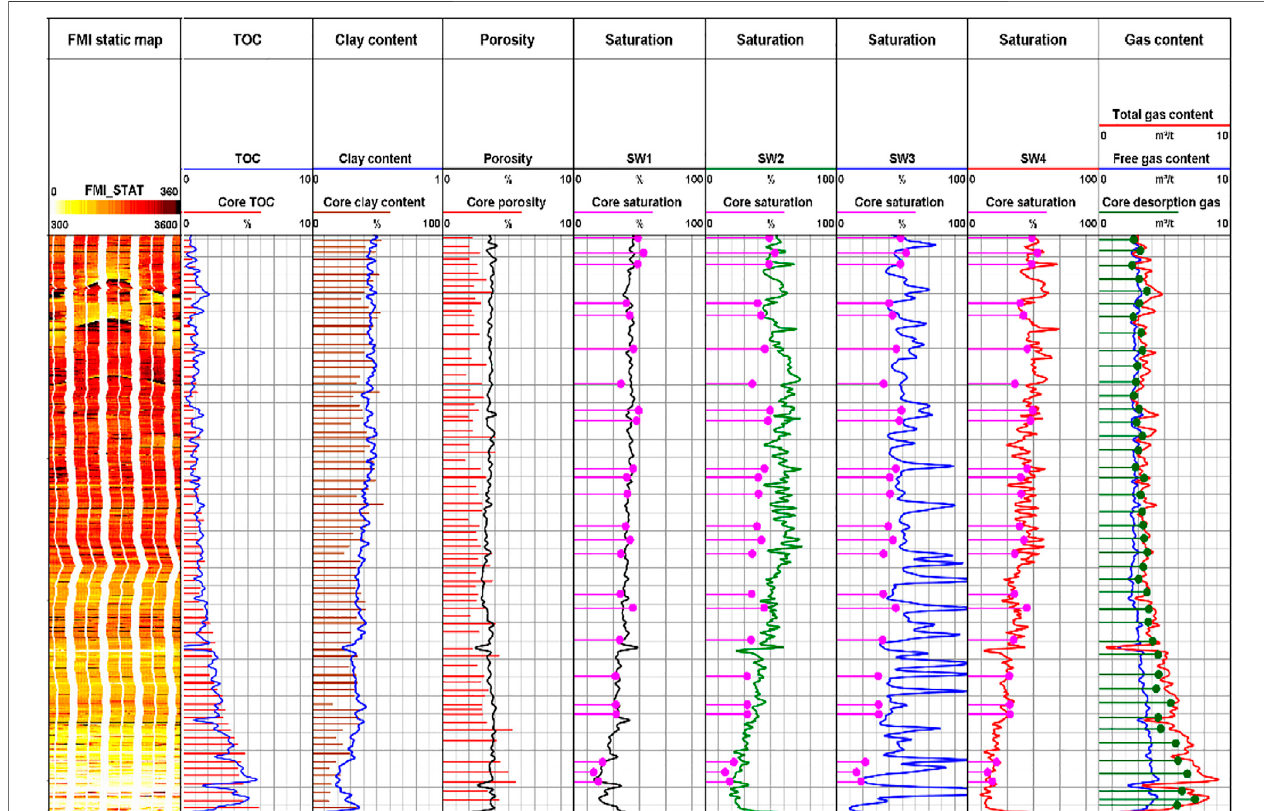
FIGURE 17 | Well logging interpretations of marine shale gas well D4, Sw4 is new model, Sw1-Sw3 are old models.